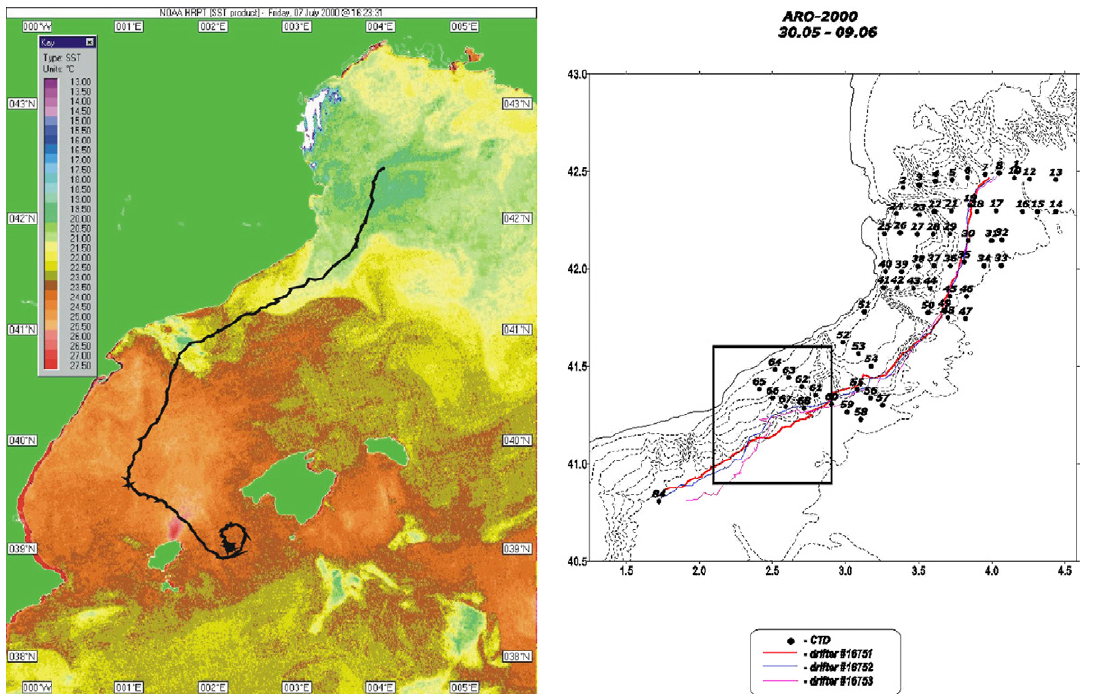
Fig. 3. – Trajectory of a drifter superimposed on top of the sea-surface-temperature field as deduced through satellite IR imagery. The inset illustrates the trajectories of three drifters during the oceanographic survey mentioned in the text. Source: Mikhail Emelianov.